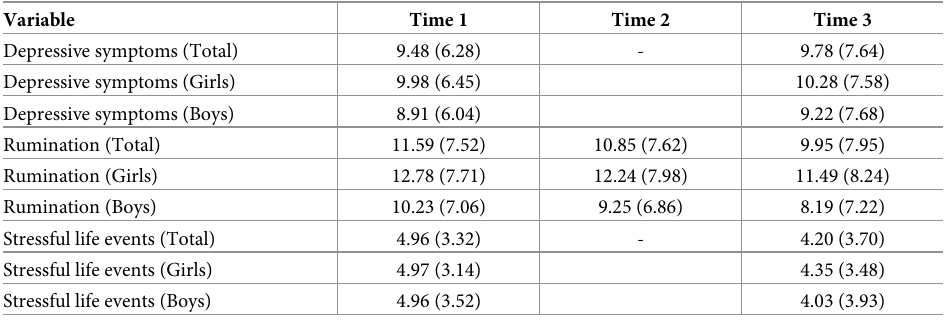
Table 1. Summary of